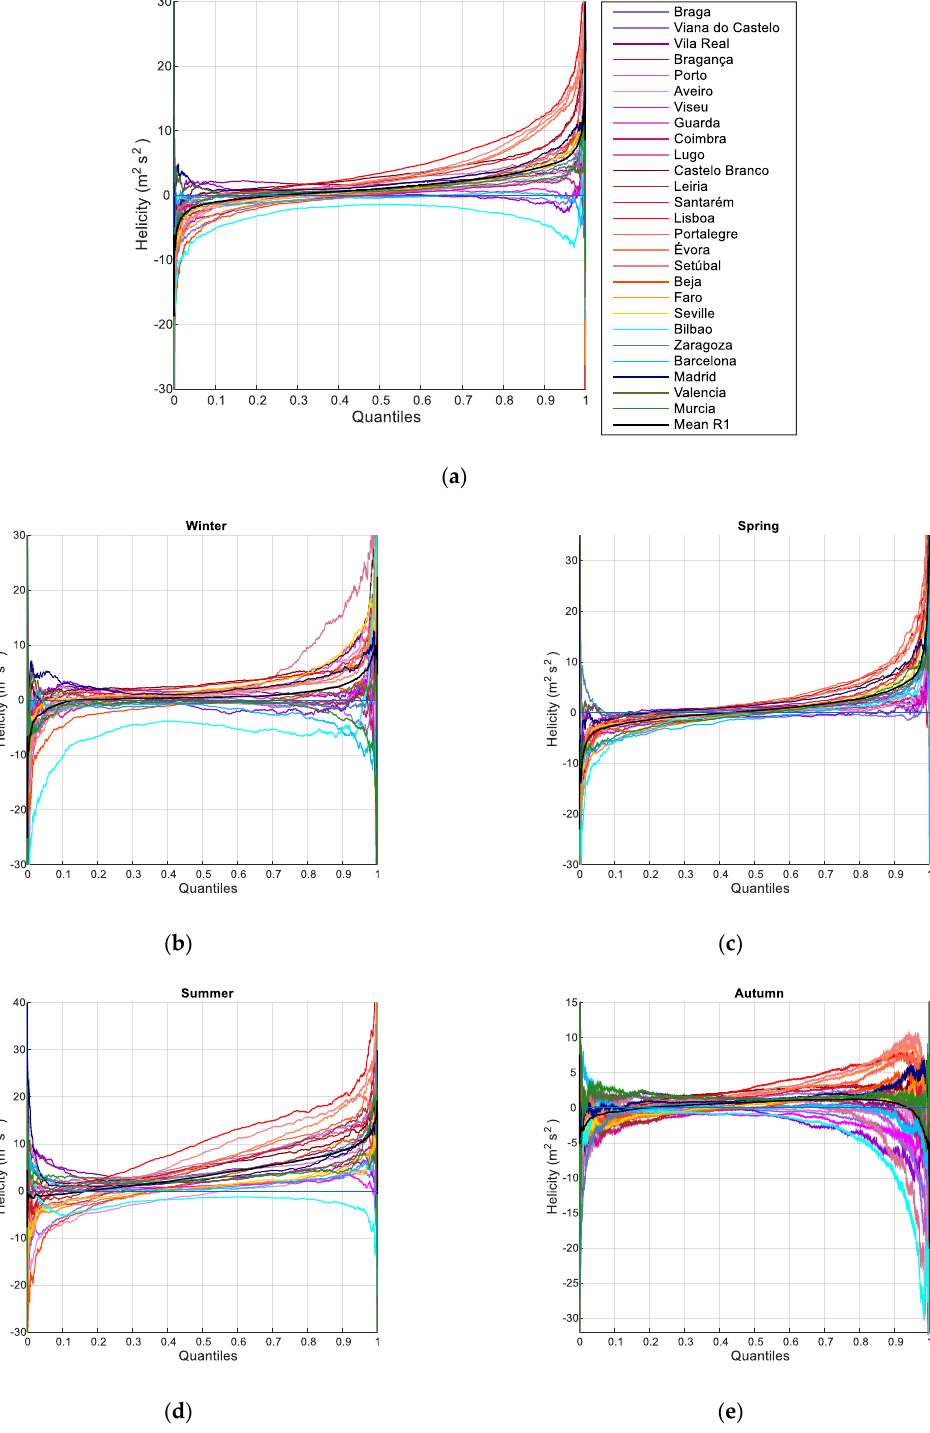
Figure 14. Absolute di ff erences (m 2 s 2 , future-historic) for helicity 0–3 km for annual and seasonal conditions, as a function of the quantiles of the corresponding empirical distributions. The black line (Mean R1) refers to the mean of region 1 (total area). ( a ) annual, ( b ) winter, ( c ) spring, ( d ) summer, ( e )